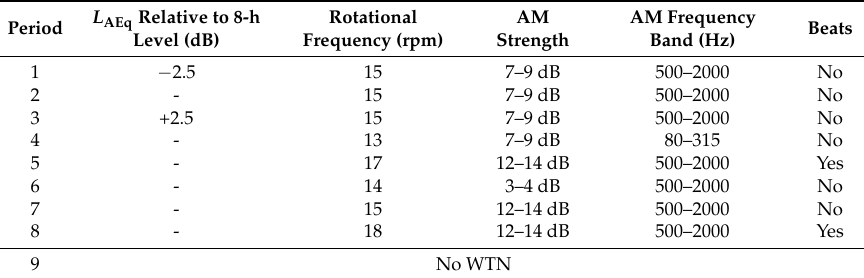
Table 2. Overview of the 400 s sound character periods within each hour in Study A.